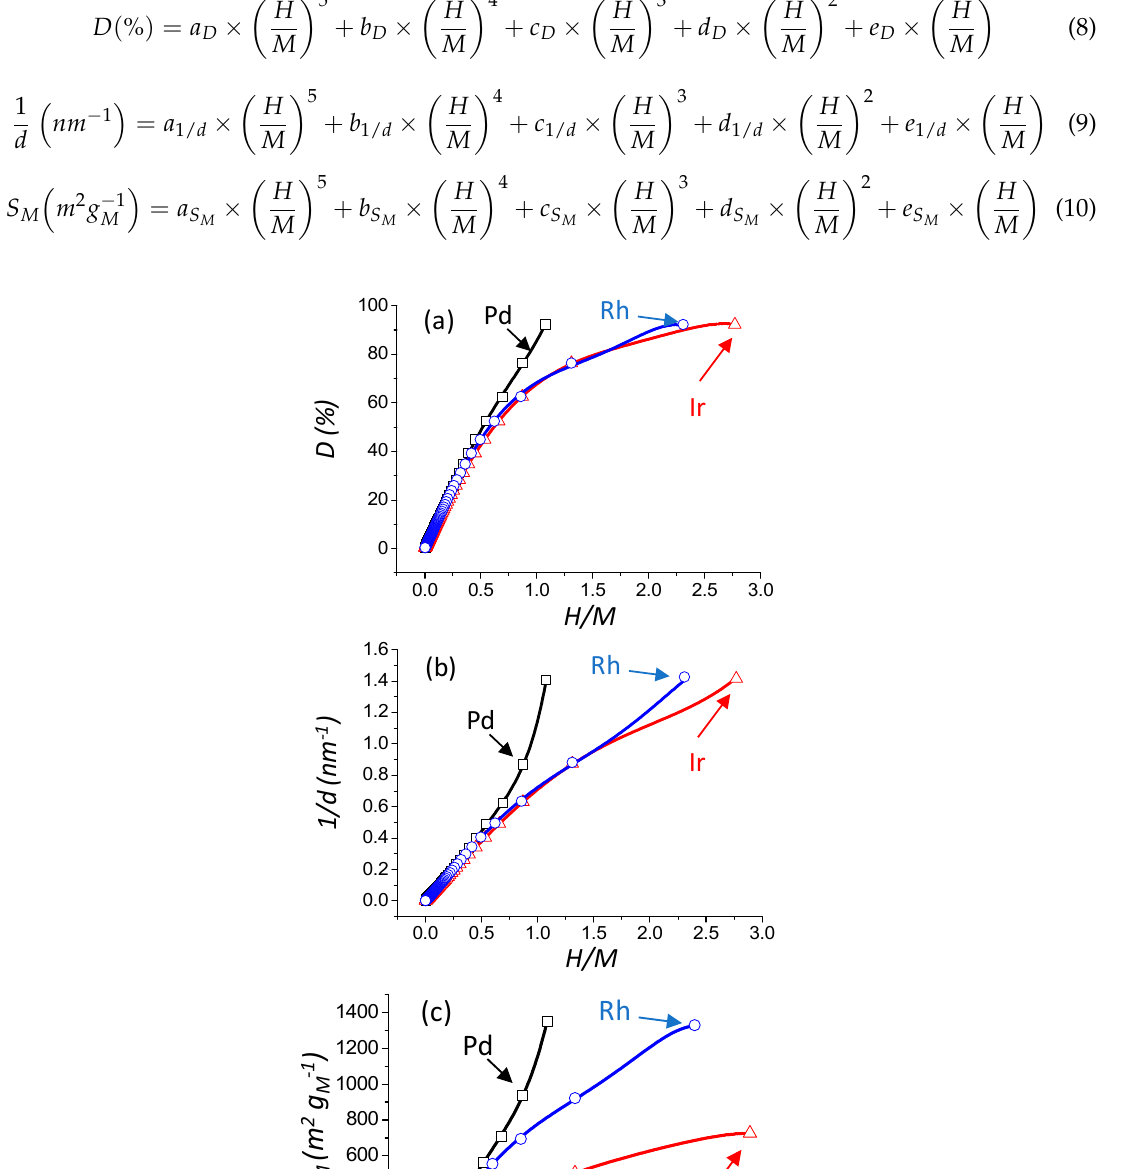
Table 4. Values of the constants (cid:1853) (cid:3026) ,(cid:1854) (cid:3026) ,(cid:1855) (cid:3026) ,(cid:1856) (cid:3026) ,and (cid:1857) (cid:3026) for Equation (11). ( M : metal; range of validity of equation 11: 0–1.08 for H /Pd, 0–2.31 for H /Rh, and 0–2.77 for H /Ir).